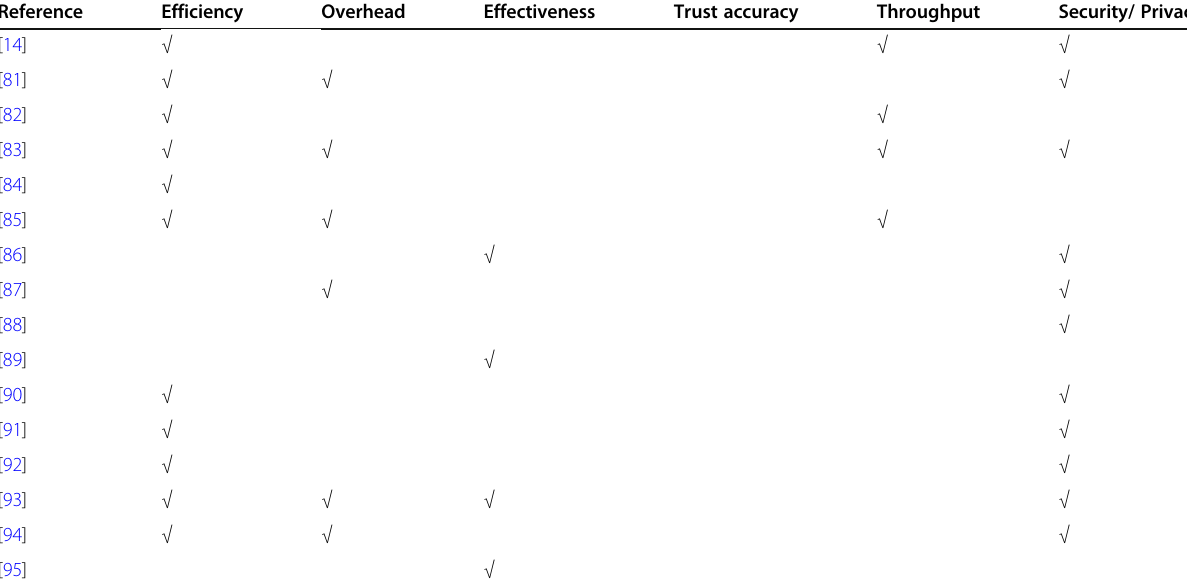
Table 8 Comparison of performance test